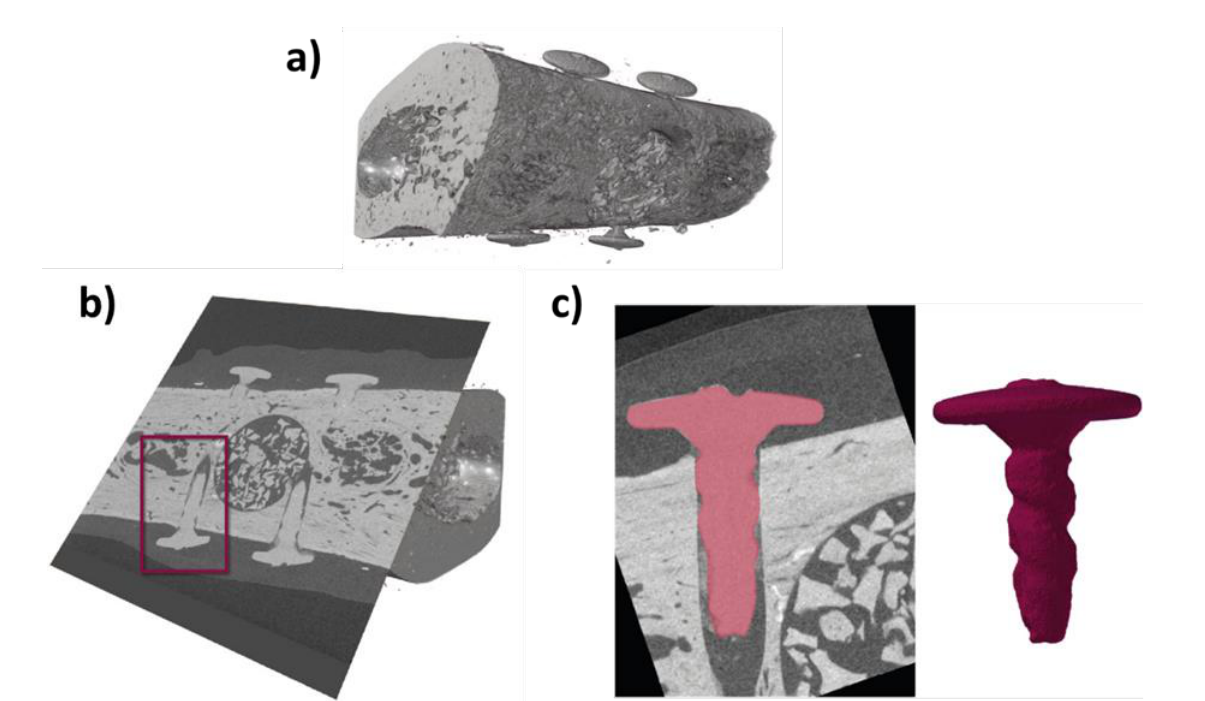
Figure 2. Demonstration of the workflow to obtain the volume and surface area values for each of the implanted screws (3.5 mm in length). µCT scans were taken from the one-week timepoint and show that the magnesium fixations screws remain largely intact. ( a ) µCT of defect; ( b ) Location of the magnesium fixation screws identified; ( c ) Extraction of screw volumes after alignment and segmentation.